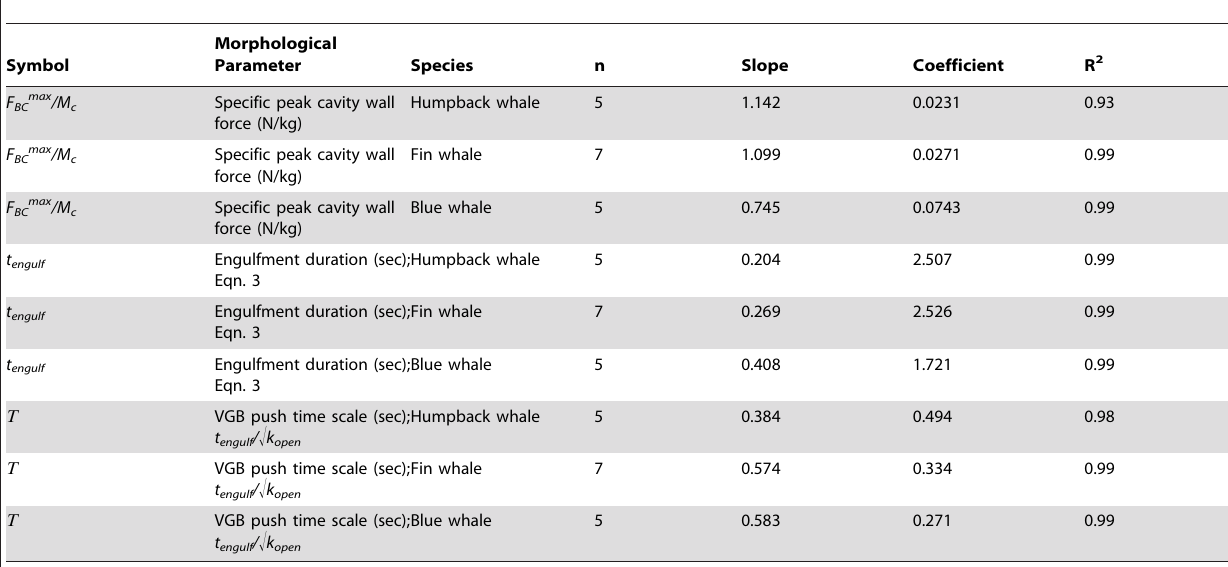
Table 6. Scaling of the buccal cavity wall force and engulfment times with respect to body length ( L body ).